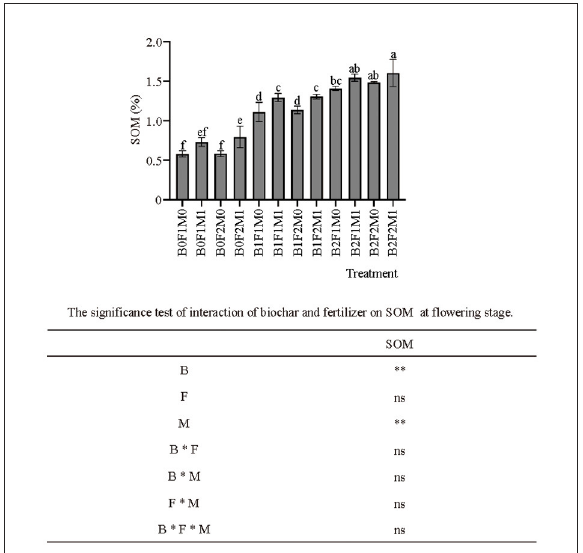
FIGURE4 Effects of biochar, inorganic fertilizer and organic fertilizer on SOM at flowering stage. Bars followed by the same letter are not significantly different according to LSD-test ( P ≤ 0.05). Bars represent standard errors of the means. ** Significant difference at p = 0.01 and ns indicates no significant difference.